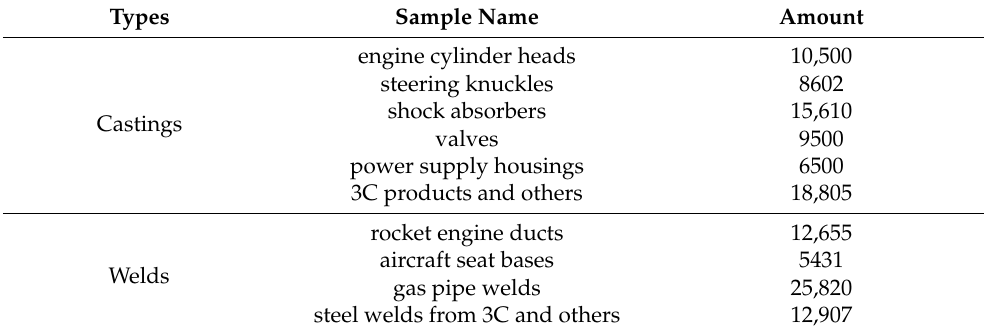
Figure 8. Some typical X-ray inspection equipment from Deepsea. ( a ) A 500 kV X-ray inspection machine, steel weld sample; ( b ) a 225 kV X-ray inspection machine, aluminum casting sample from a bicycle; ( c ) a 225 kV X-ray inspection machine, aluminum casting sample from automobile. Table 3. DSXImage database